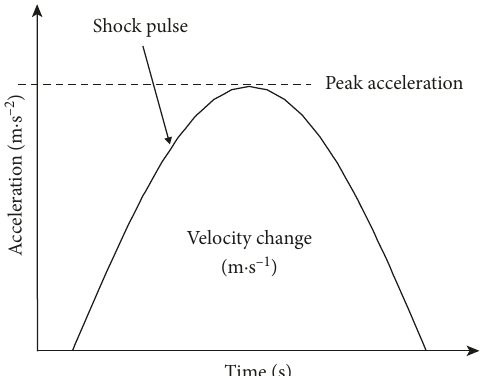
Figure 2: Relationship between time, peak acceleration, and ve- locity change for a half-sine shock pulse. Table 2: Relationship between velocity change, peak acceleration, and the damage area of apples. ∗